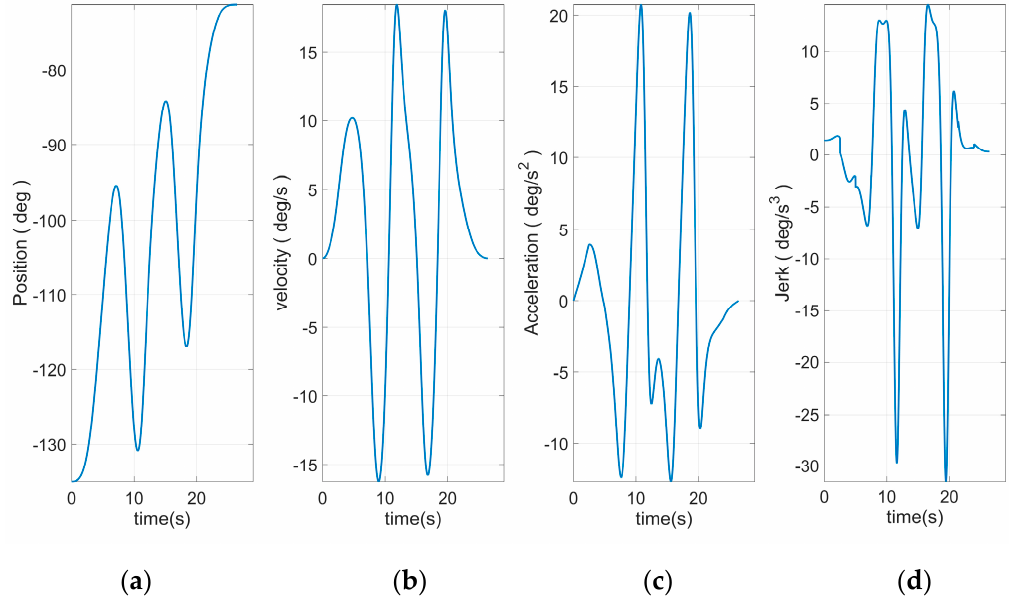
III over time by using seven segments S-curve. ( c ) Acceleration of axis III over time by using seven segments S-curve. ( d ) Jerk of axis III over time by using seven segments S-curve.